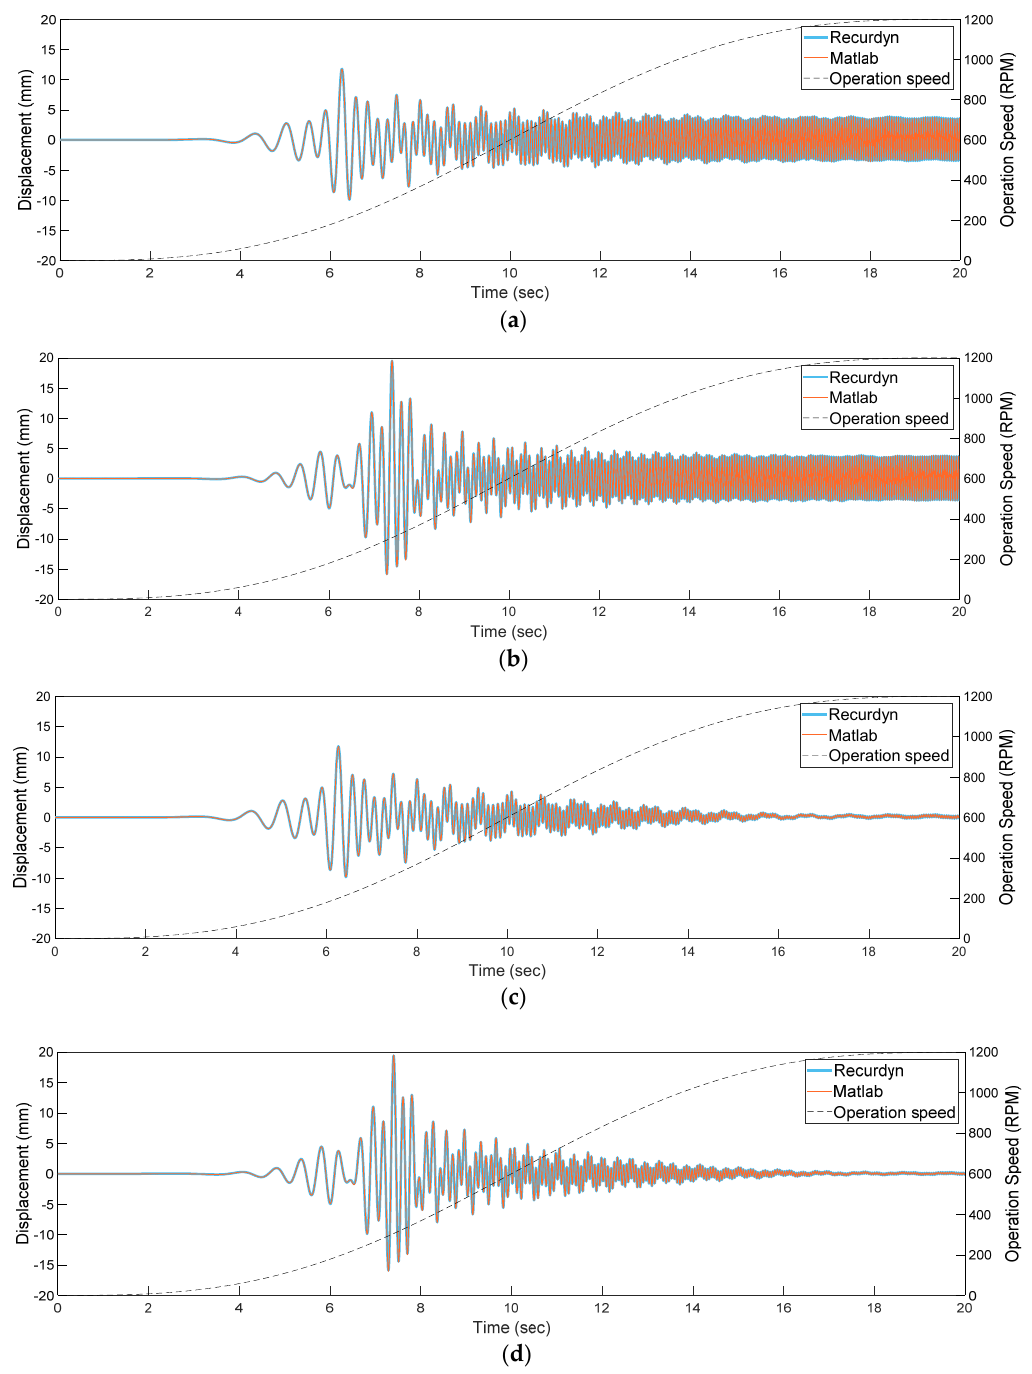
Figure 6. Comparison of dynamic analysis results obtained with the nonlinear analytical model and commercial software: ( a ) tub front center horizontal displacement, ( b ) tub front center vertical displacement, ( c ) drum front center horizontal displacement, and ( d ) drum front center vertical displacement.